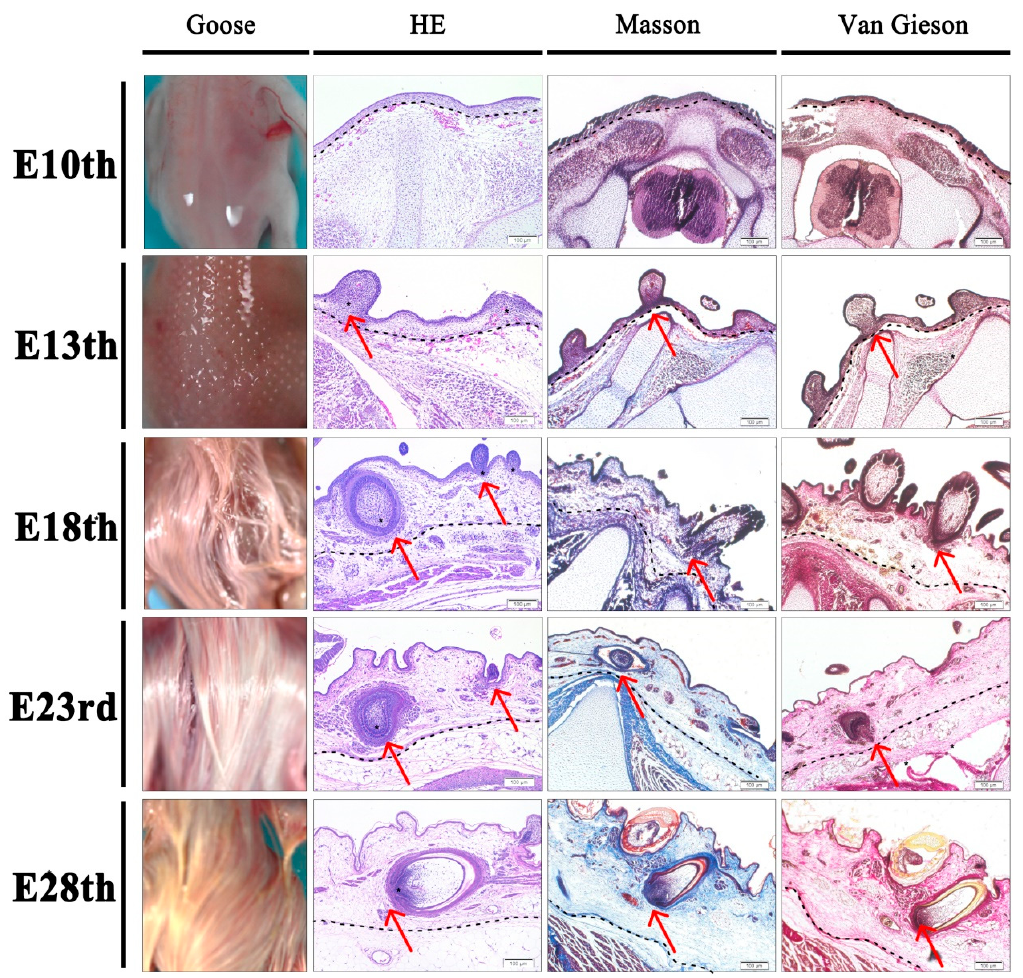
Figure 1. Developmental pattern of skin and feather follicles in embryonic Zhedong white geese. The vertical rows show the time gradient, and the horizontal rows show the results of different stains. Magnified: 100×; Bar: 100 μ m.